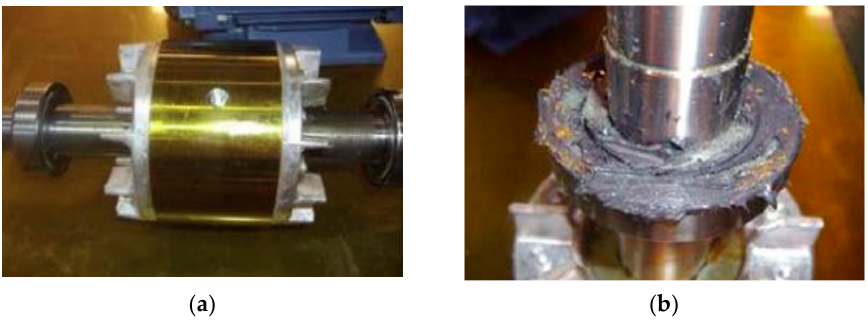
Figure 3. Induction motor fault type. ( a ) Rotor fault. ( b ) Bearing fault.